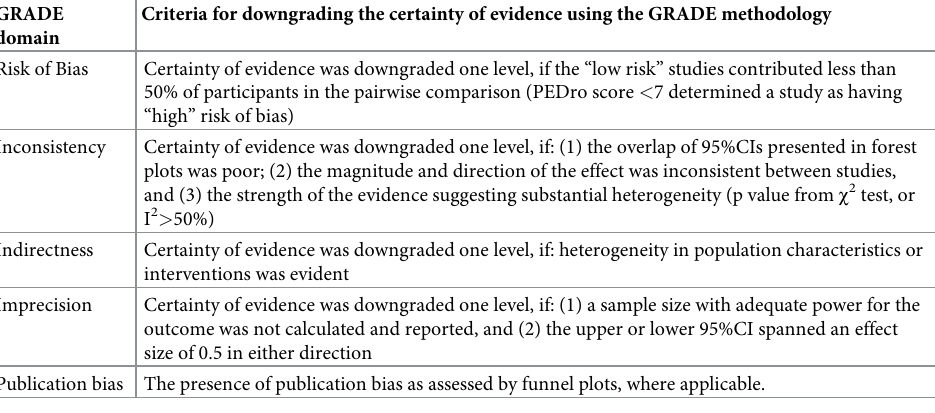
Table 1. Criteria used for grading the certainty of evidence. GRADE